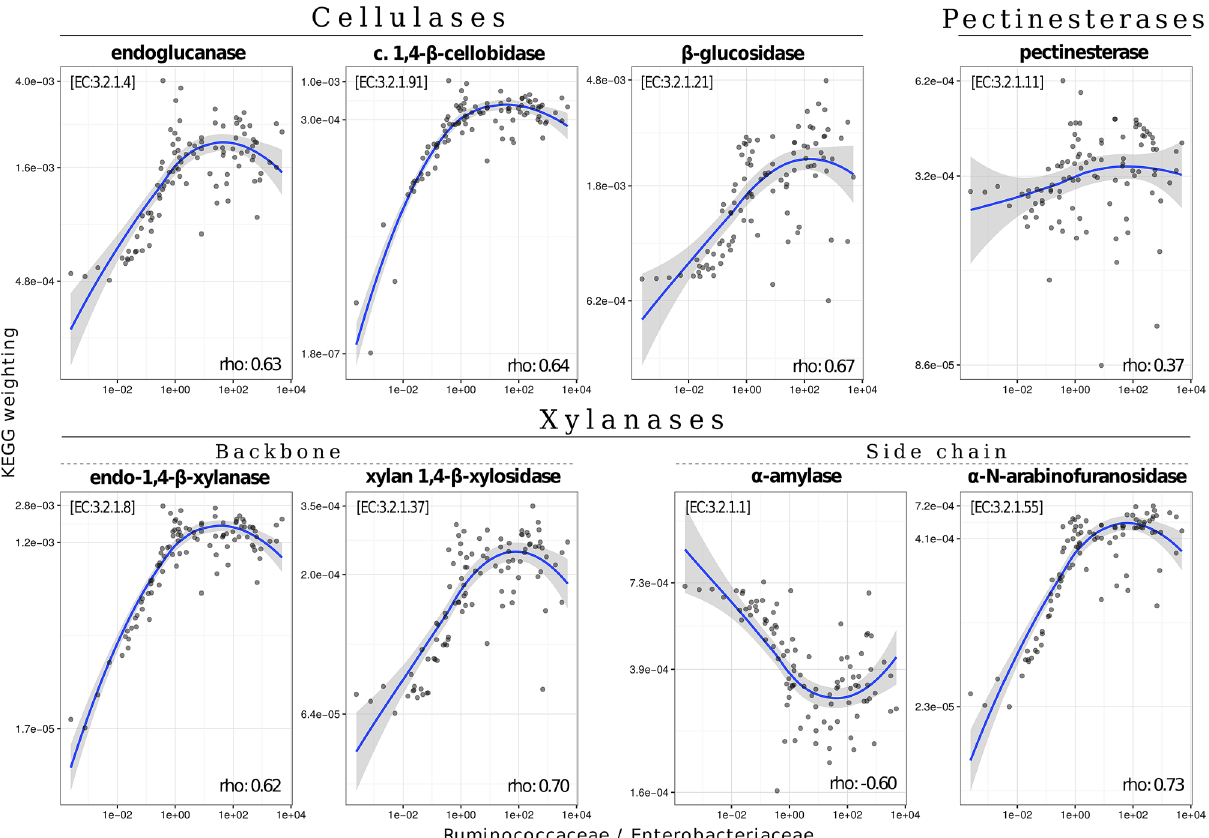
Figure 3. Correlation between the weighted importance of inferred enzyme-specific genes (i.e. KEGGs) (y-axis) related to vegetable fiber degradation and the Ruminococcaceae / Enterobacteriaceae ratio (x-axis). KEGG weighting values refer to predicted adjusted abundances in the entire gut microbial community. Spearman’s rank-order coefficients were significant in all cases ( P <